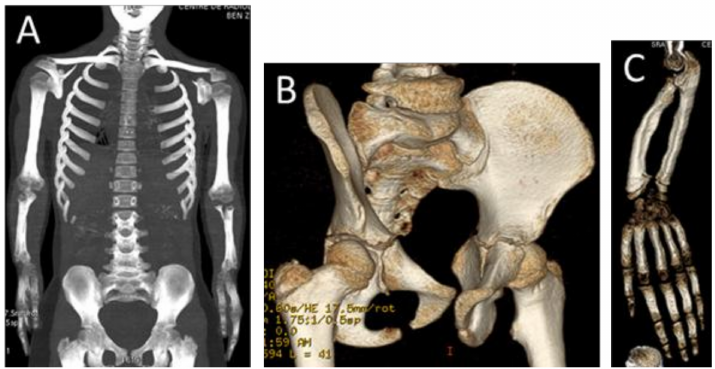
Figure 2. Reconstruction CT scan of the whole skeleton showed rhizomelia, metaphyseal widening of the humeri and a deficient number of ribs (10 instead of 12) ( A ). Pelvic bones showed coxa valga and iliac–ischial dysplasia due to defective ossification of the ischial rami ( B ). The forearms showed Madelung´s deformity (short radius and radial dislocation with lateral and posterior bowing, a triangular epiphysis due to absence of the growth plate medially, and posterior dislocation the lower end of the ulna), the carpal bones were wedged between the distal ends of the radius and protruding